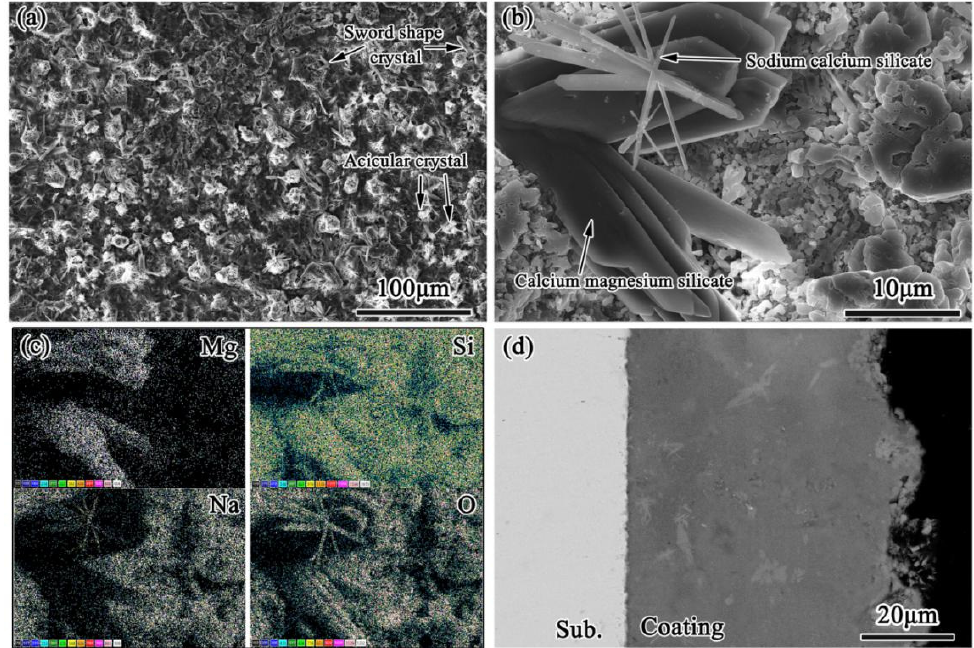
Figure 11. Low-magnification morphology ( a ), high-magnification surface image ( b ), elemental map-scan profile (analyzed by EDS) ( c ), and cross-sectional image ( d ) of the MSS with GCC after 100 h oxidation at 650 °C.